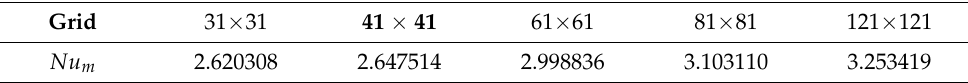
Table 2. Grid independence study at Da = 10 − 4 , Ra = 10 4 , ε = 0.8, φ = 0.01, n =